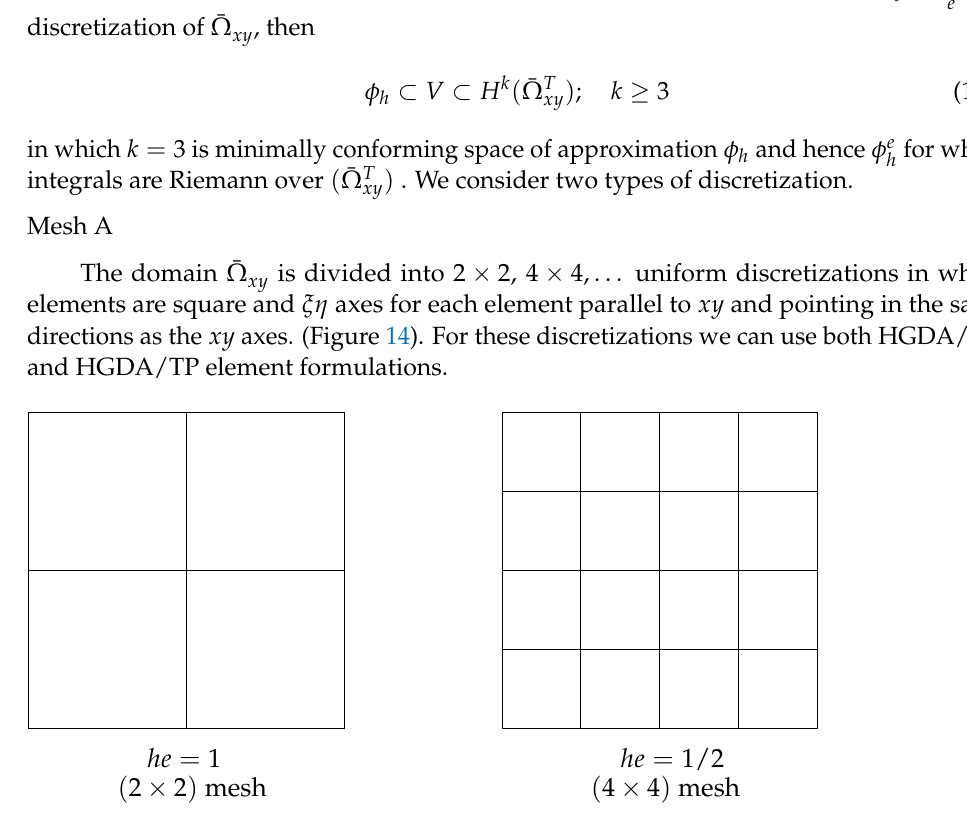
Figure 14. Mesh A: Discretizations with square elements (undistorted).